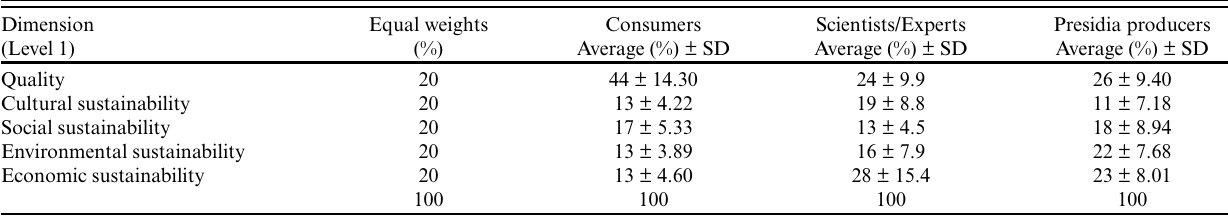
Table 3 . Weights assigned to each of five dimensions by the three presidia stakeholder categories.